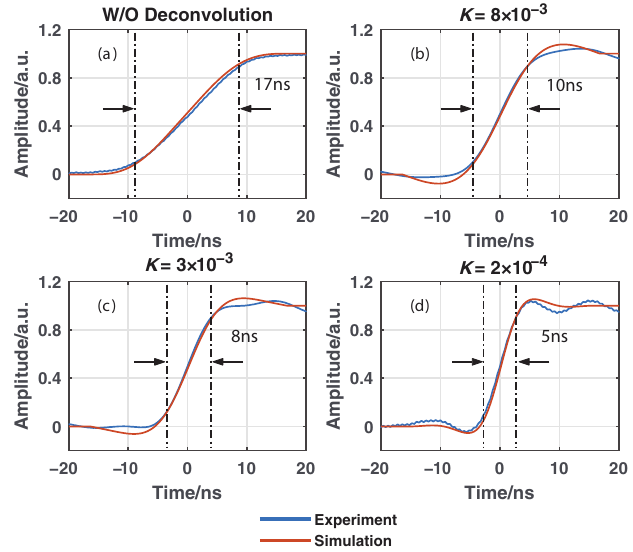
Figure 6. Rising edge of ( a ) the original Stokes Raman signal without using the Wiener deconvolution and the estimated Stokes Raman signals using the Wiener deconvolution with ( b ) K = 8 × 10 − 3 ; ( c ) K = 3 × 10 − 3 ; ( d ) K = 2 × 10 − 4 . The blue curves are results based on experimental data, and the red curves are simulated results.